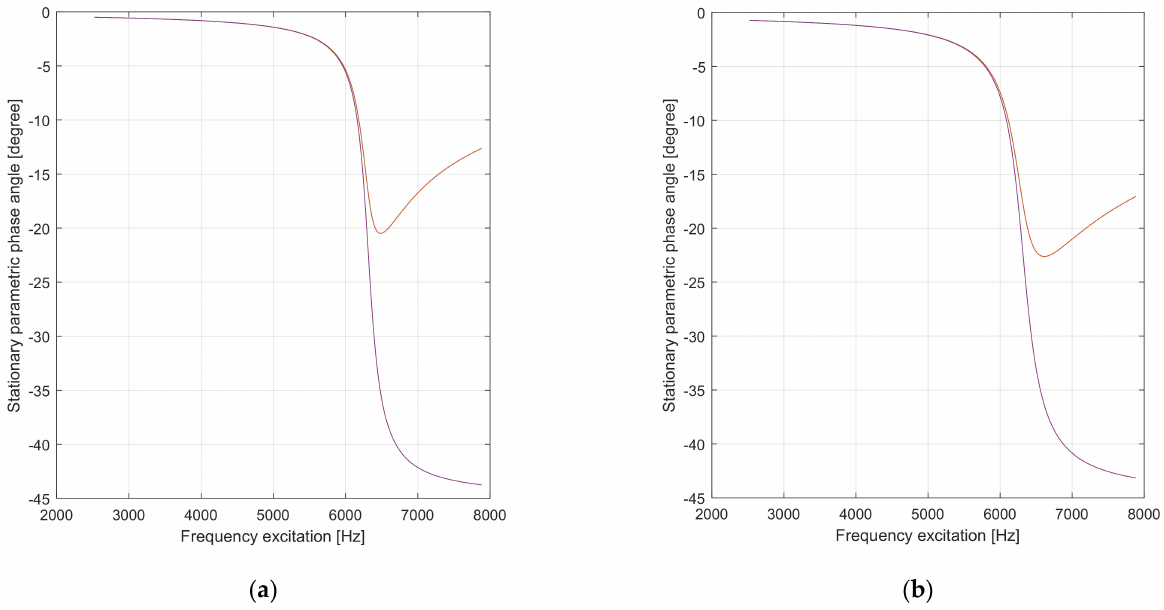
Figure 18. Stationary parametric phase angle Ψ of the bowl for χ nB = 0.10, where µ = 0.754 × 10 − 4 . ( a ) ζ = 0.0216 ( b ) ζ =